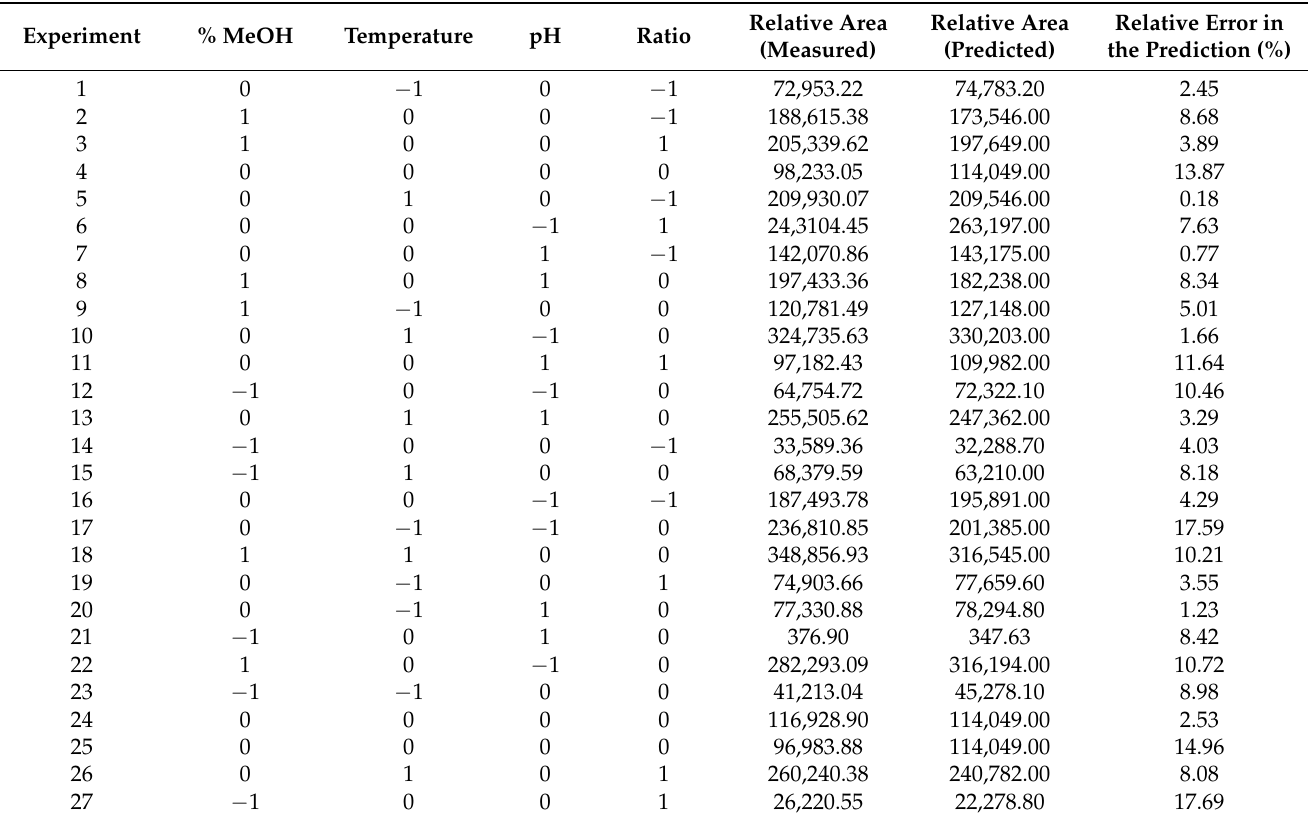
Table 1. Box-Behnken design experiment to optimize the extraction of total anthocyanins from purple potato.